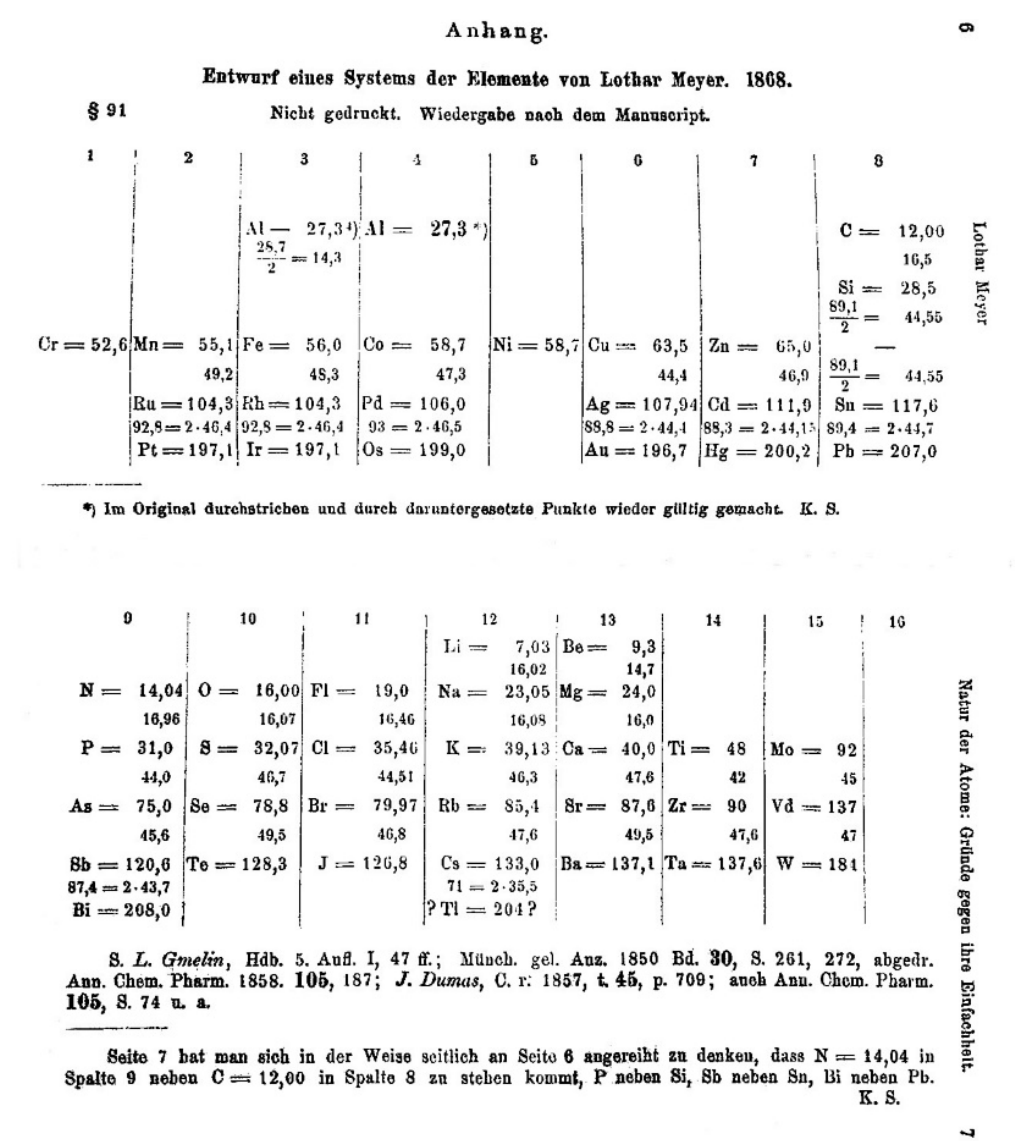
Figure 5. Meyer‘s unpublished draft of an elements‘ system. Scan from K. Seubert, Das natürliche System der chemischen Elemente, 2 nd edi- tion, Engelmann, Leipzig, 1913 , pp.